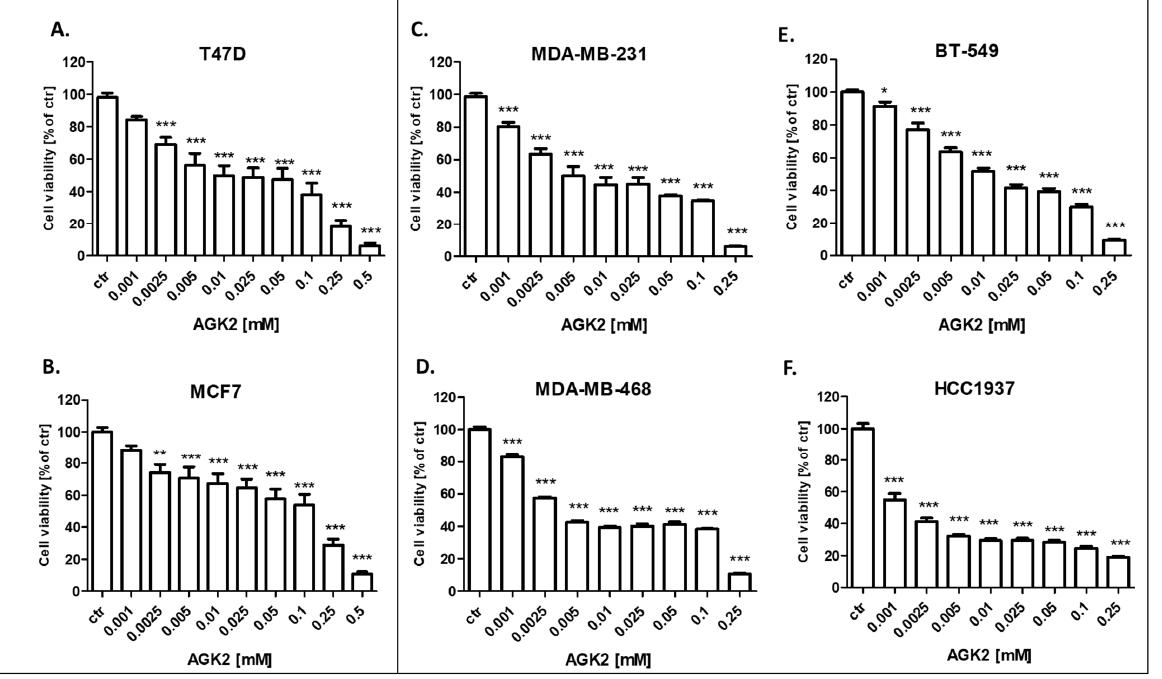
Figure 6. Effect of AGK2 on the viability of the ( A ) T47D, ( B ) MCF7, ( C ) MDA-MB-231, ( D ) MDA- MB-468, ( E ) BT-549 and ( F ) HCC1937 BC cells after 96 h with 0.001–0.5 mM of the drug in the MTT assay. The data are presented as the means ± standard deviation ( ± SD); one-way ANOVA, Tukey’s post-hoc testing; * p < 0.05, ** p < 0.01, *** p <